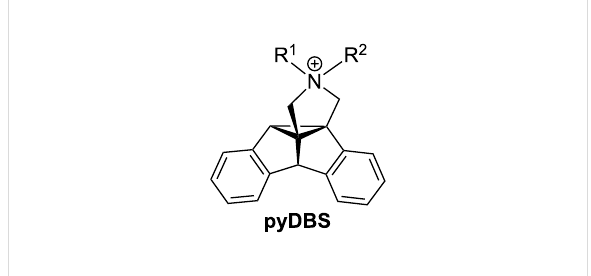
Figure 1: General structure of pyrrolidinium-annelated diben- zosemibullvalenes ( pyDBS)